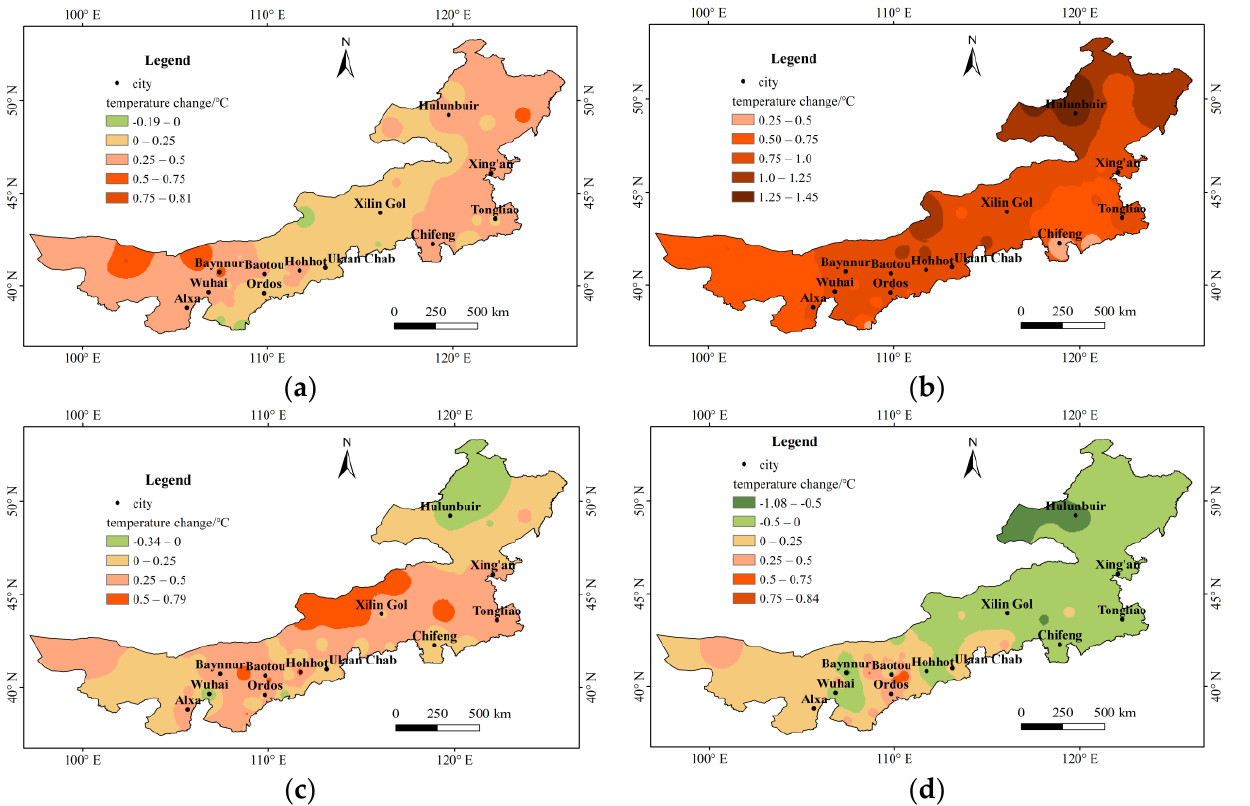
Figure 5. Temperature inclination rate in Inner Mongolia during 1970 – 2017.